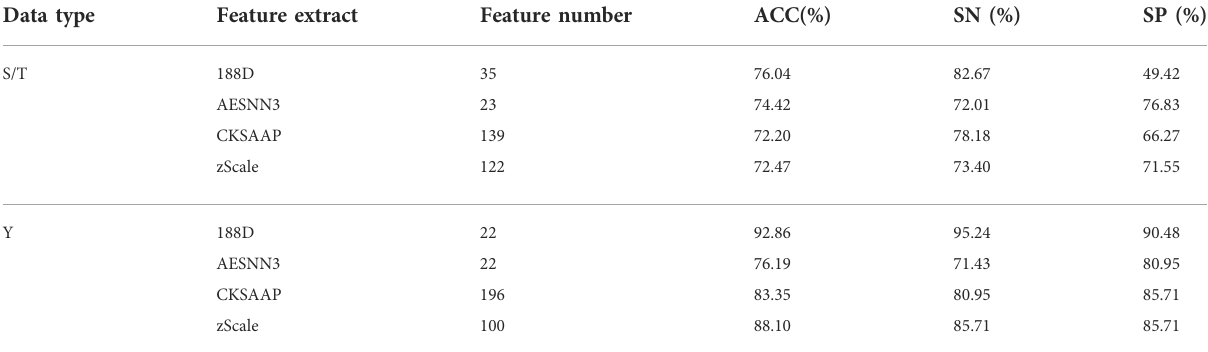
TABLE 2 Accuracy on the same independent test datasets of optimal feature